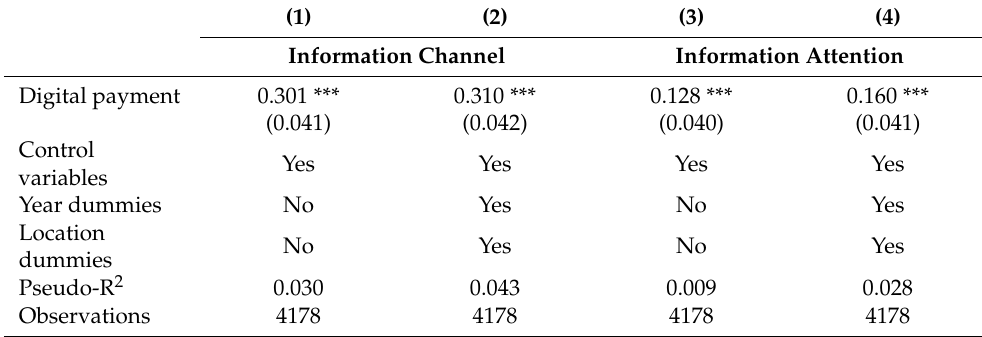
Table 10. Digital payment adoption and information effects (estimated by ordered probit models).